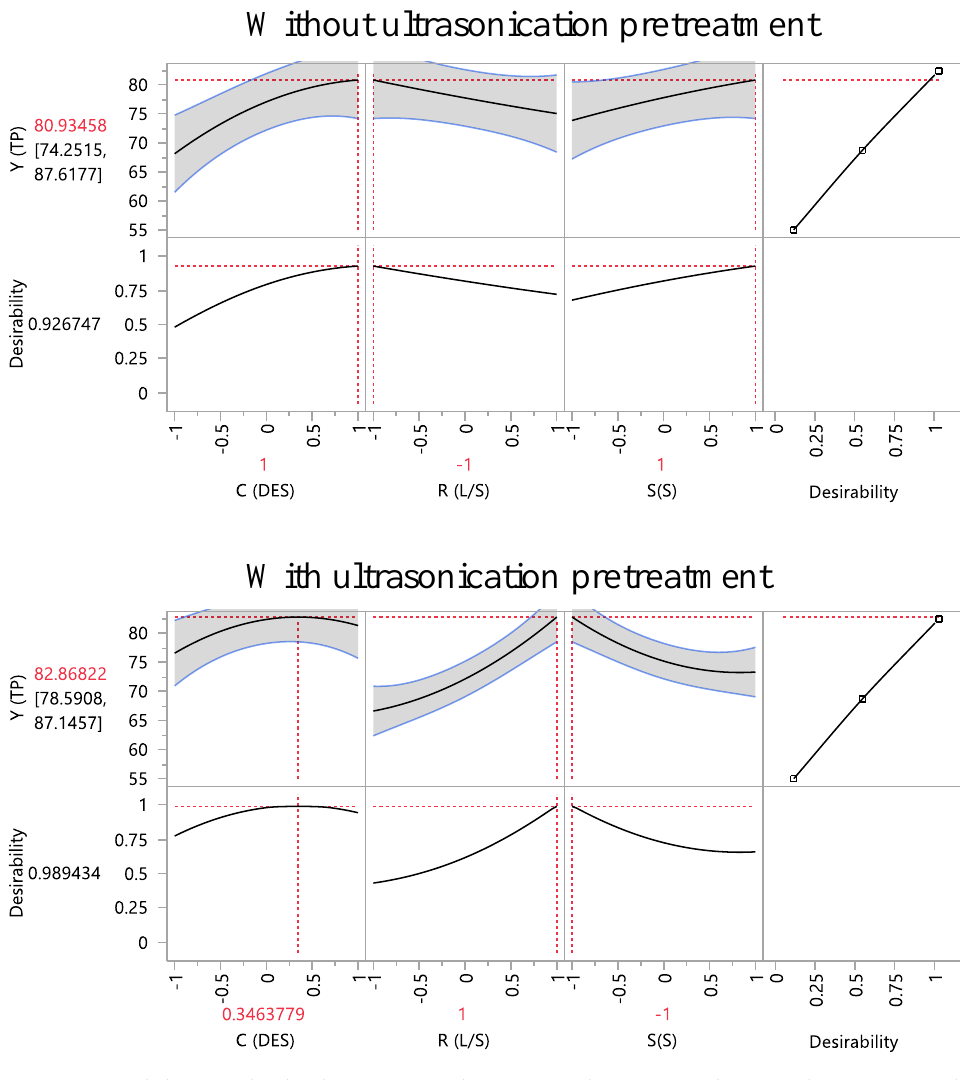
Figure 3. Desirability graphs displaying optimal settings and maximum theoretical extraction yields for total polyphenols (mg GAE g − 1 dm). Table 5. Optimal predicted conditions and maximum predicted values ( ± sd) for the extraction of M. oleifera with and without ultrasonication pretreatment.